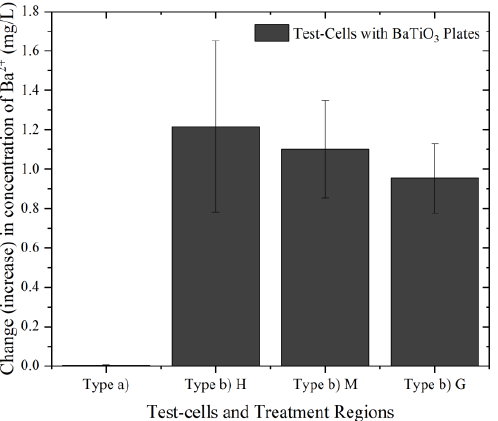
Figure 7. Effects of PEF treatment on the concentration of iron ions in yeast suspension using different types of chambers. Error bars show standard deviation (n = 3). Table 2. Statistical analysis of the experimental results of iron ions concentration (mg/L).